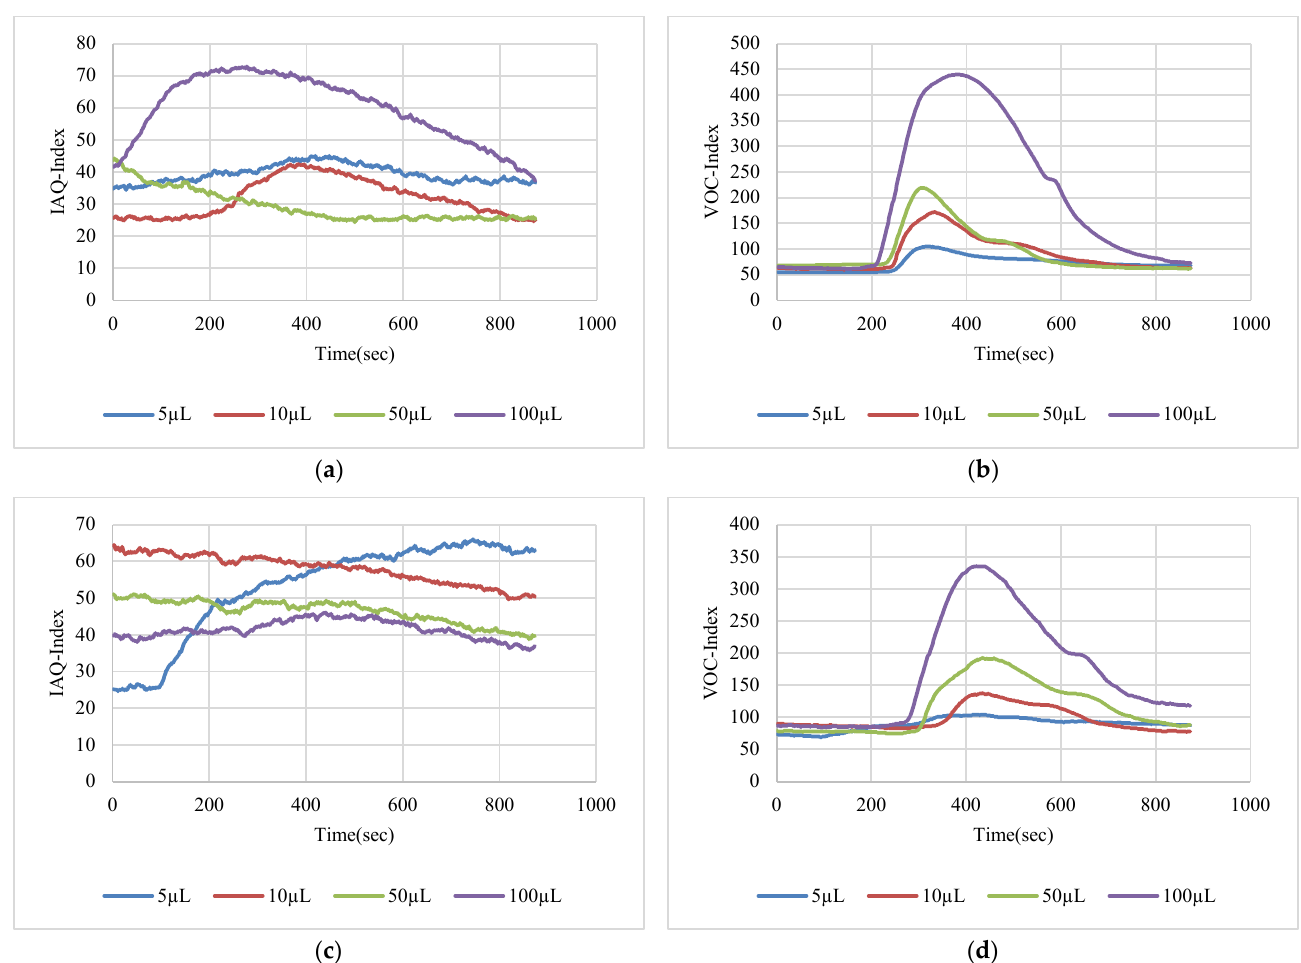
Figure 17. Test results for hexane: ( a ) BME688 40 cm, ( b ) SGP41 40 cm, ( c ) BME688 100 cm, ( d ) SGP41 100 cm.